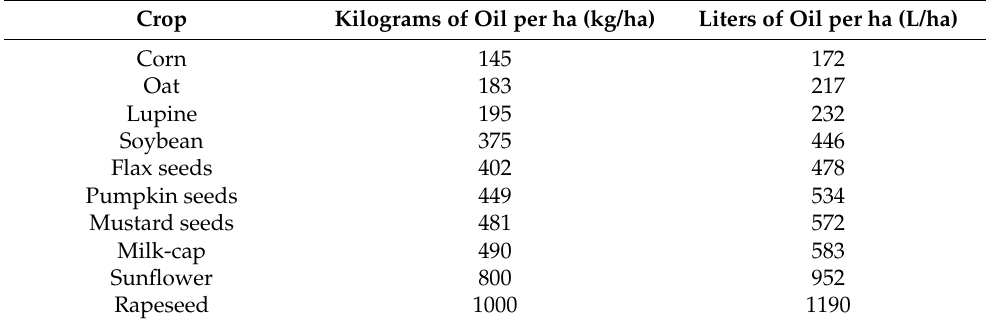
Table 1. Production of oil from crops per ha.